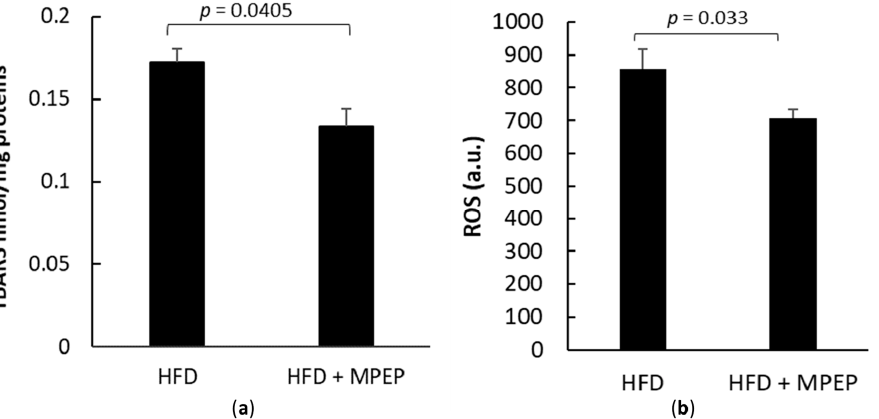
Figure 8. TBARS and ROS in obese mice. ( a ) TBARS in liver homogenates from obese mice after 7 weeks of HFD administration, treated with MPEP 20 mg/Kg or vehicle; ( b ) ROS in liver homogenates from obese mice after 7 weeks of HFD administration treated with MPEP 20 mg/Kg or vehicle. HFD: high-fat diet + vehicle group; HFD + MPEP: high-fat diet + 20 mg/Kg MPEP group. Results are mean ± SE of 6 individual determinations.